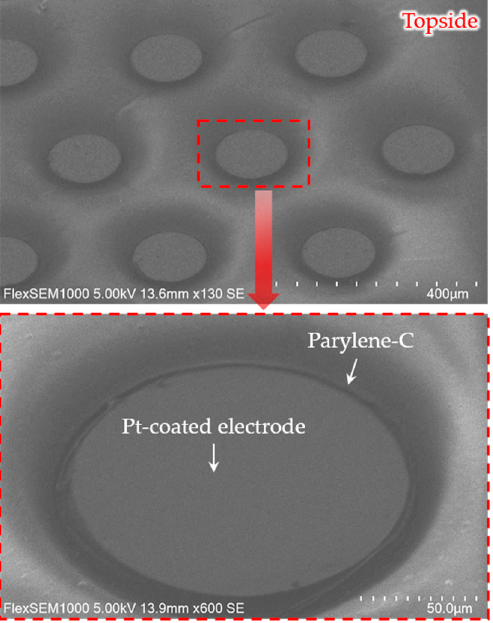
Figure 6. SEM images of the electrode array insulated by parylene-C, excluding the electrode sites.